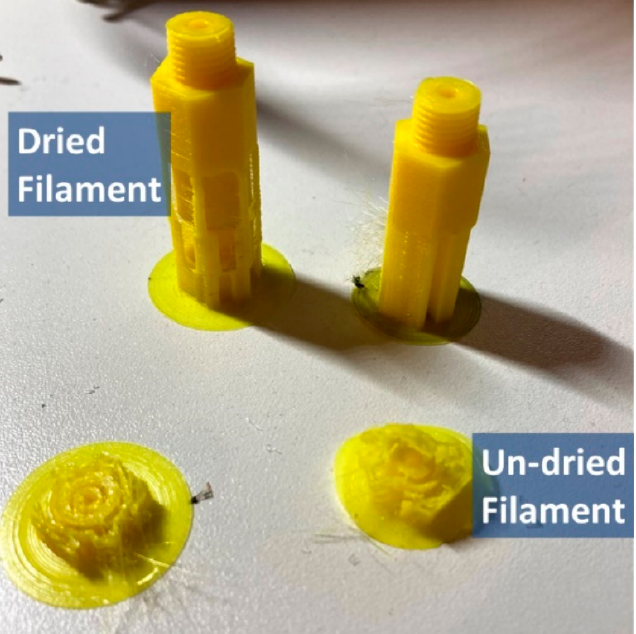
Figure 24. The dried filament showed significantly stronger layer adhesion and smoother surface finish.